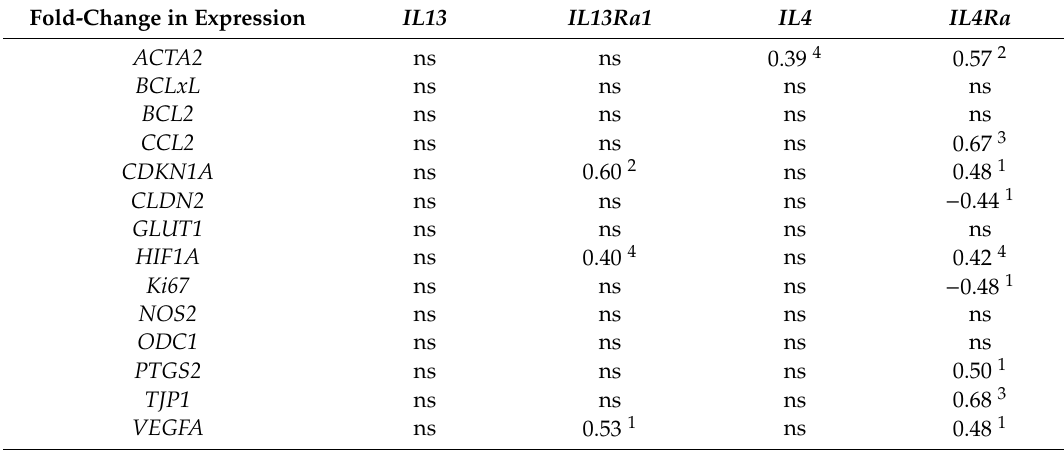
Table 9. Correlation pattern between fold-change in expression (tumor-to adjacent) of IL4 , IL4Ra , IL13 , and IL13Ra1 and expression of representative mediators relevant for cancer growth in CRC patients. Fold-Change in Expression